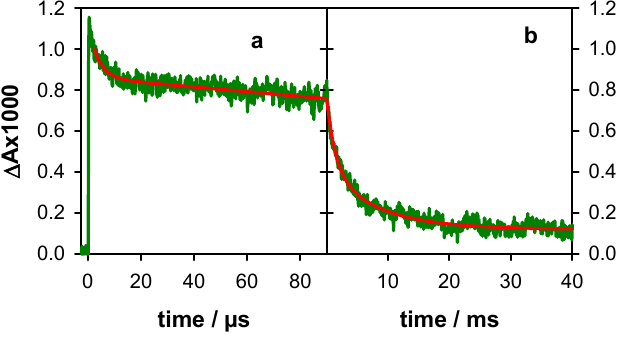
Figure 5. Survival probability P t of the total G radical population in TEL21 / K + , estimated by the transient absorption signals at 512 nm, recorded on the microsecond ( a ) and the millisecond ( b ) time-scales. Red lines correspond to fits with bi-exponential functions.